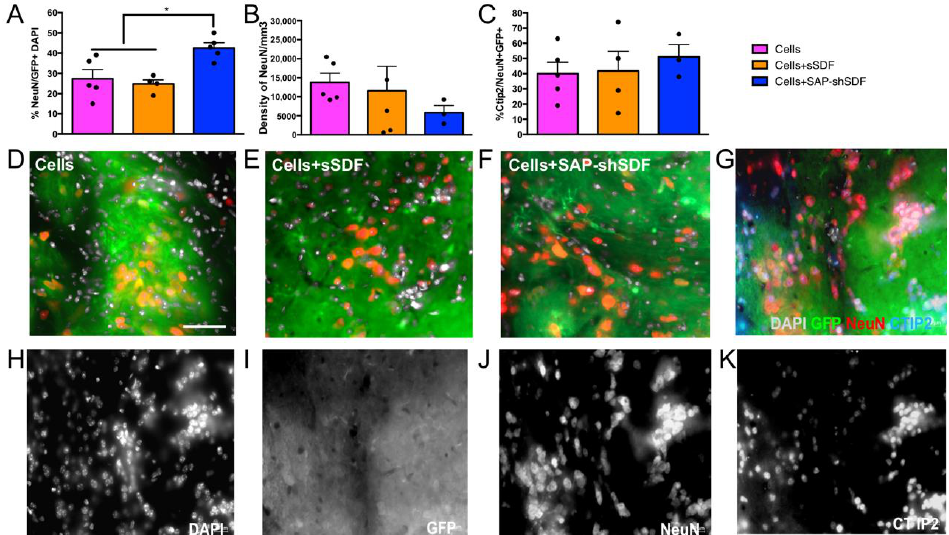
Figure 4. Homeostatic hydrogel shows maturation of cell grafts and neuronal specification. ( A ) Quantification of percentage of NeuN + DAPI + cells within delineated GFP+ graft, ( B ) quantification of NeuN + density within the delineated GFP+ graft, ( C ) quantification of percentage of Ctip2+ NeuN+ cells within the delineated GFP+ graft, ( D – F ) representative images showing NeuN + DAPI + cells within GFP+ grafts, scale bar = 50 μ m, ( G – K ) representative images in Cells + sSDF groups expressing DAPI, GFP, NeuN, and CTIP2. Data represent mean ± standard error of mean (SEM; *, p < 0.05).